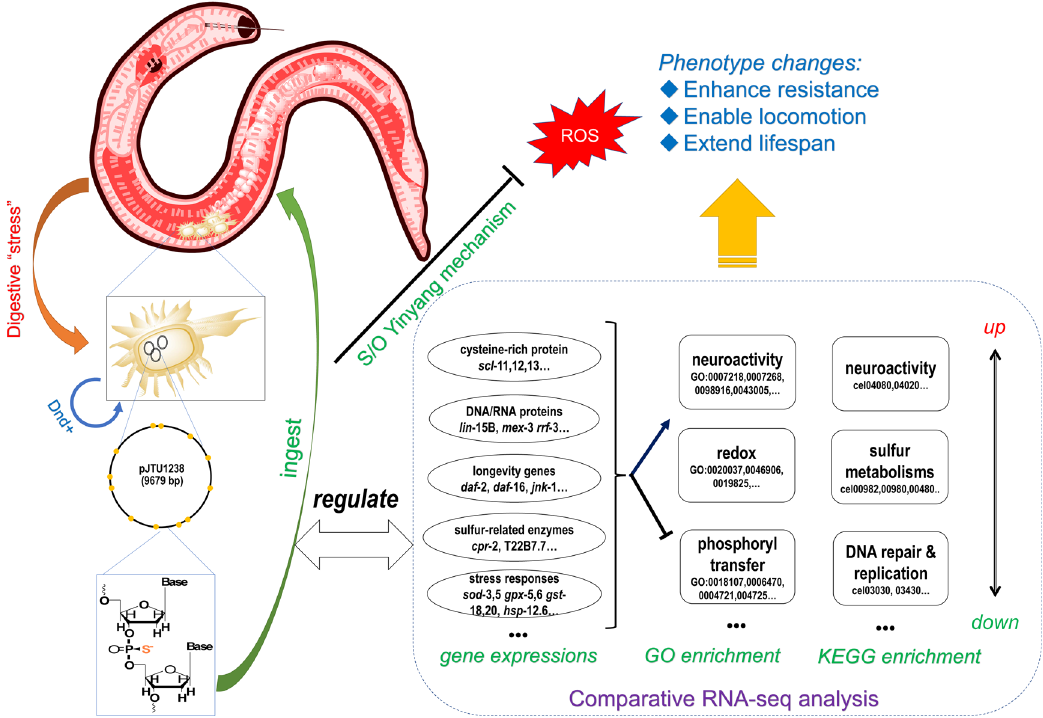
Fig. 8 The plausible mechanism for the phenotype changes of C. elegans fed on PT-bacterial diet. The nematodes (pink-colored) uptakes dnd -gene bioengineering E. coli OP50 (brown-colored), in which plasmid and genome DNA undergo phosphorothioation by Dnd function proteins. The bacterial PT- DNA is thus ingested by the nematodes, converting ROS to reductive species via sulfur-oxygen one-atom chemistry. Simultaneously, the bacterial PT-DNA leads to globally interference on gene expressions of scl -11, 12, 13 … The system-biological regulation is characterized by down-regulation of phosphoryl transfer GO terms and DNA repair/replication in KEGG enrichment, but up-regulation of neuroactivity. The overall effects enhance stress-resistance, enable locomotion, and extend